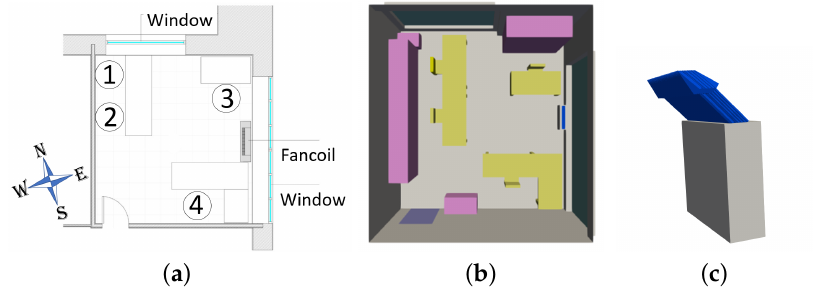
Figure 1. ( a ) Office schematic; ( b ) overview of the furniture layout inside the office; ( c ) fan-coil schematic with vector inlet at 45 ◦